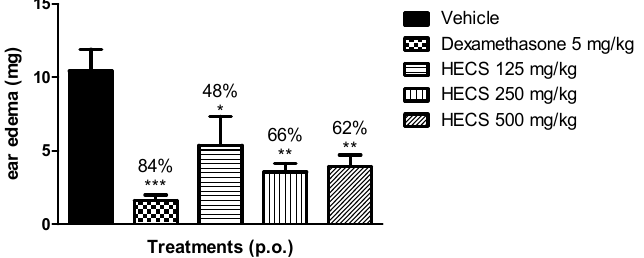
Figure 2. Effect of the hydroalcoholic extract of C. sicyoides —HECS (125, 250 and 500 mg/kg through the oral route (p.o.) in ear edema model induced by xylene. The results are expressed as the mean ± standard error of the mean (S.E.M.), and statistical significance was determined by one-way analysis of variance (ANOVA) followed by Dunnett’s test; * p < 0.05, ** p < 0.01, *** p < 0.001 compared to the control group (vehicle). The percentage corresponds to the reduction of the mean difference in weight (mg) of the ears in the control group ( n = 8).